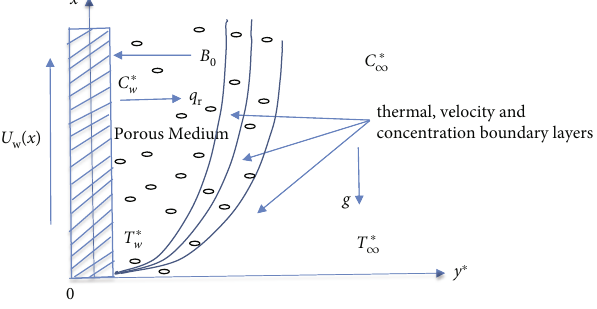
Figure 1: The fl uid fl ow and coordinate